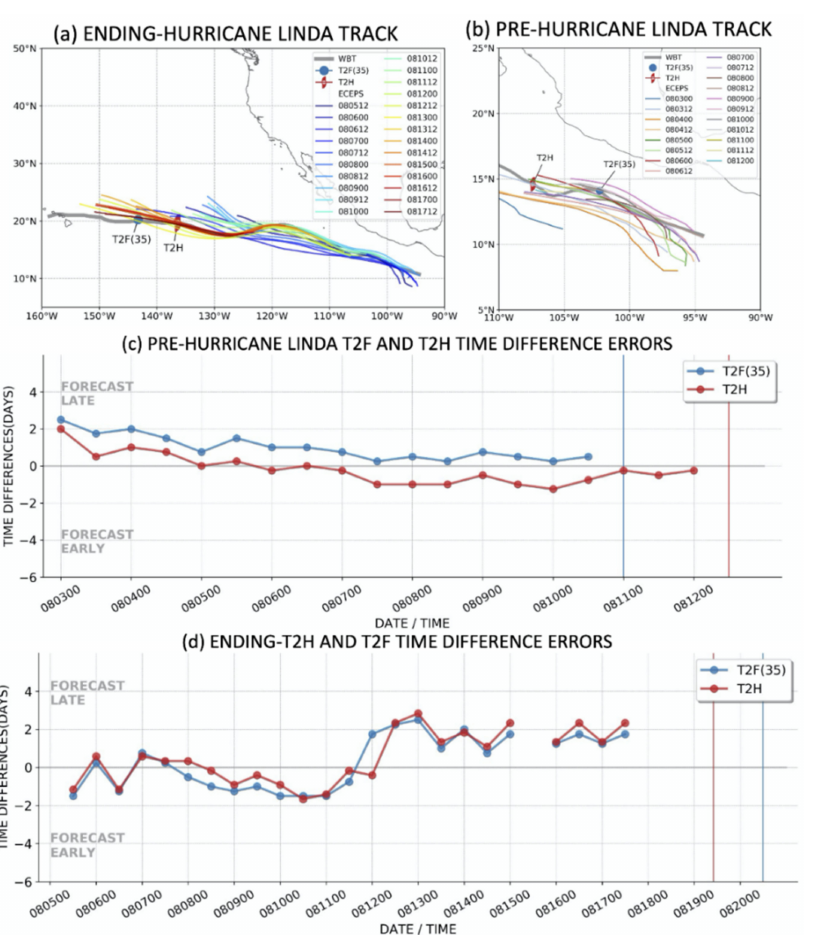
Figure 3. Summary of the ECEPS pre-formation and ending-stage predictions of the Hurricane Linda (2021) lifecycle. Track forecast initial times (MMDDHH) are indicated in the insets for the ( a ) ending stage and ( b ) pre-formation stage, and the T2F(35) and T2H timing errors for the pre-formation and for the ending-stage are displayed in panels ( c , d